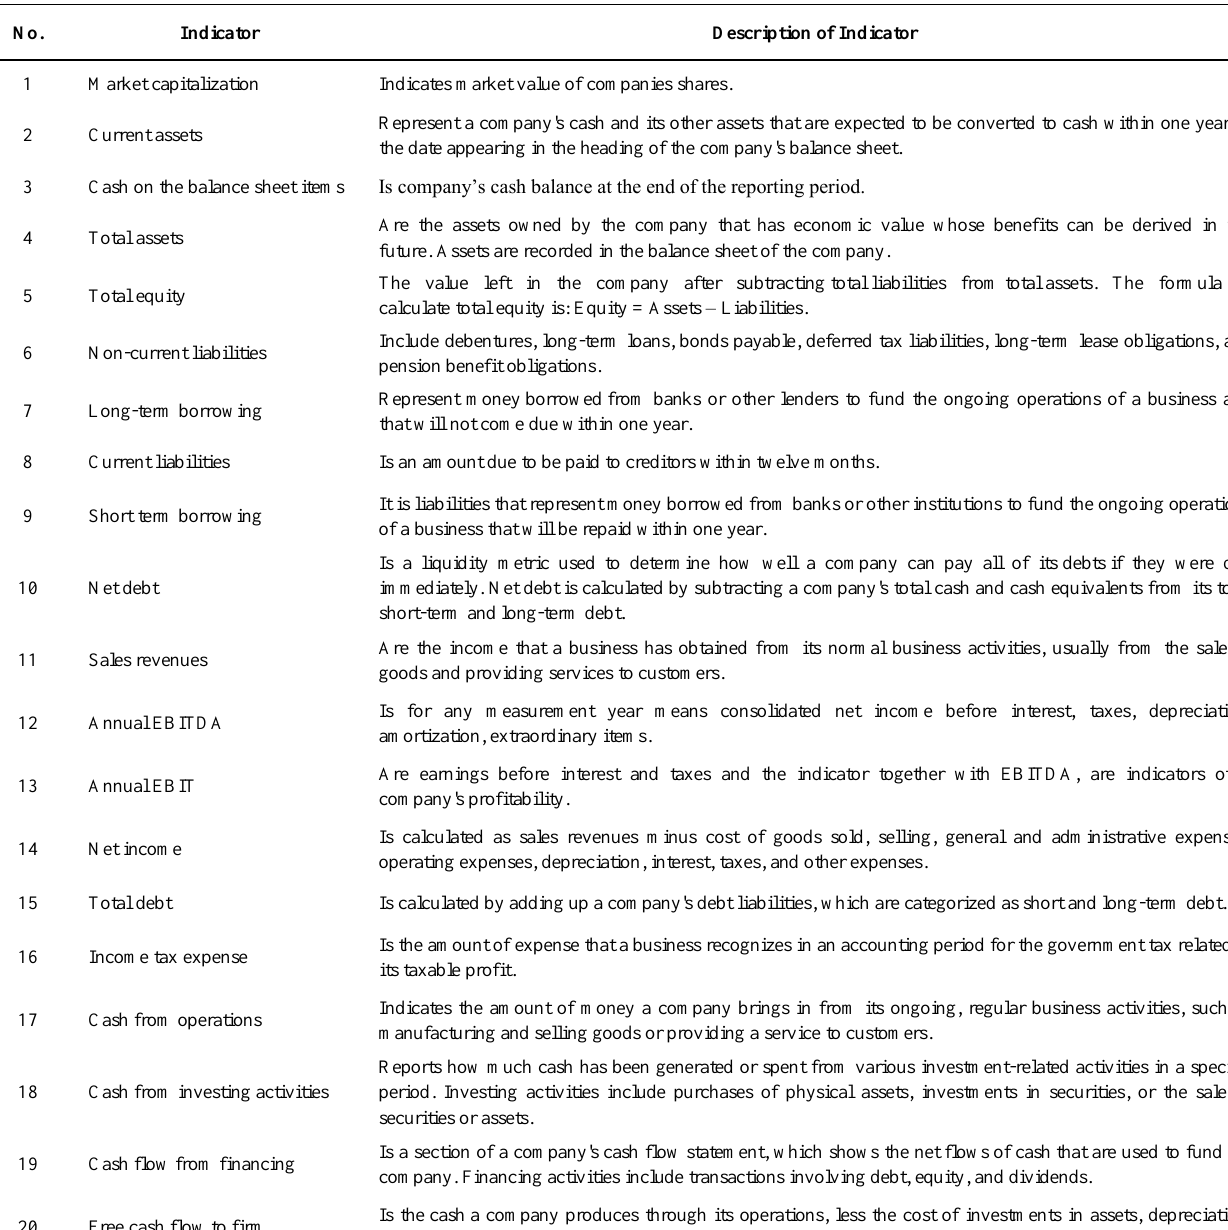
Table 1. Nordic countries stock market listed companies’ absolute value indicators